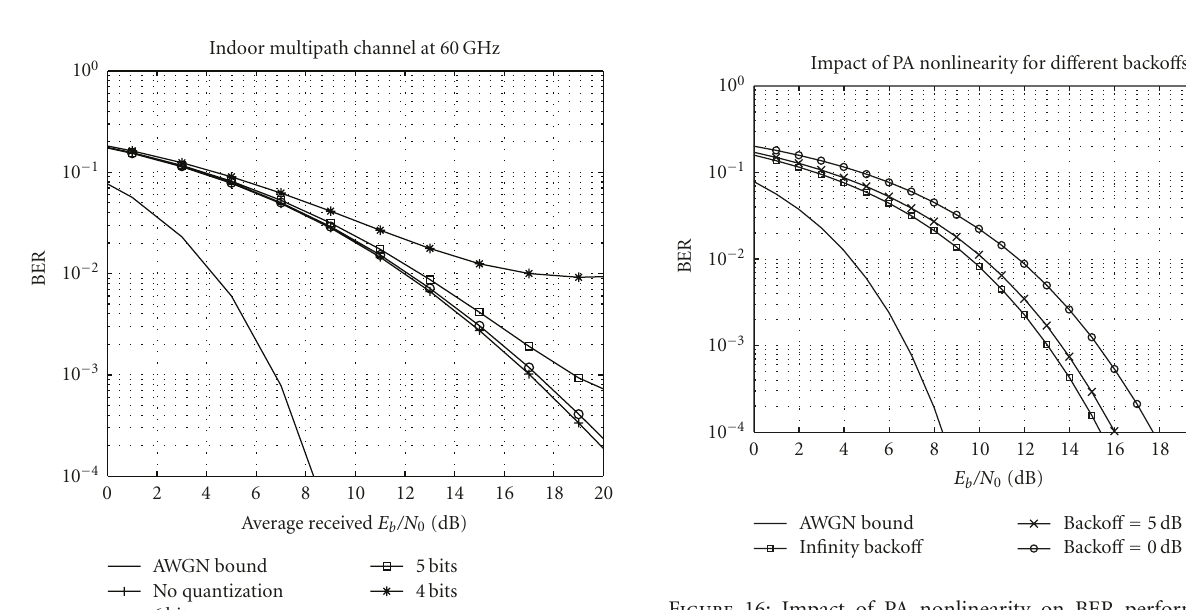
Figure 16: Impact of PA nonlinearity on BER performance of